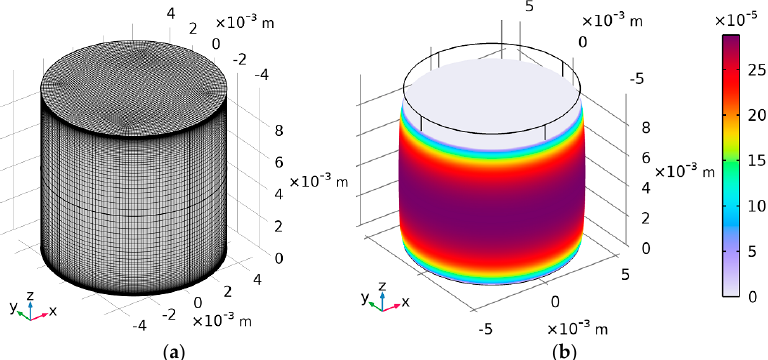
Figure 9. ( a ) FEM mesh for one of the models r/h = 0.5 ( r = 5 mm, h = 10 mm). ( b ) Result for von Mises stresses with deformation e z = 10%, ν = 0.48.